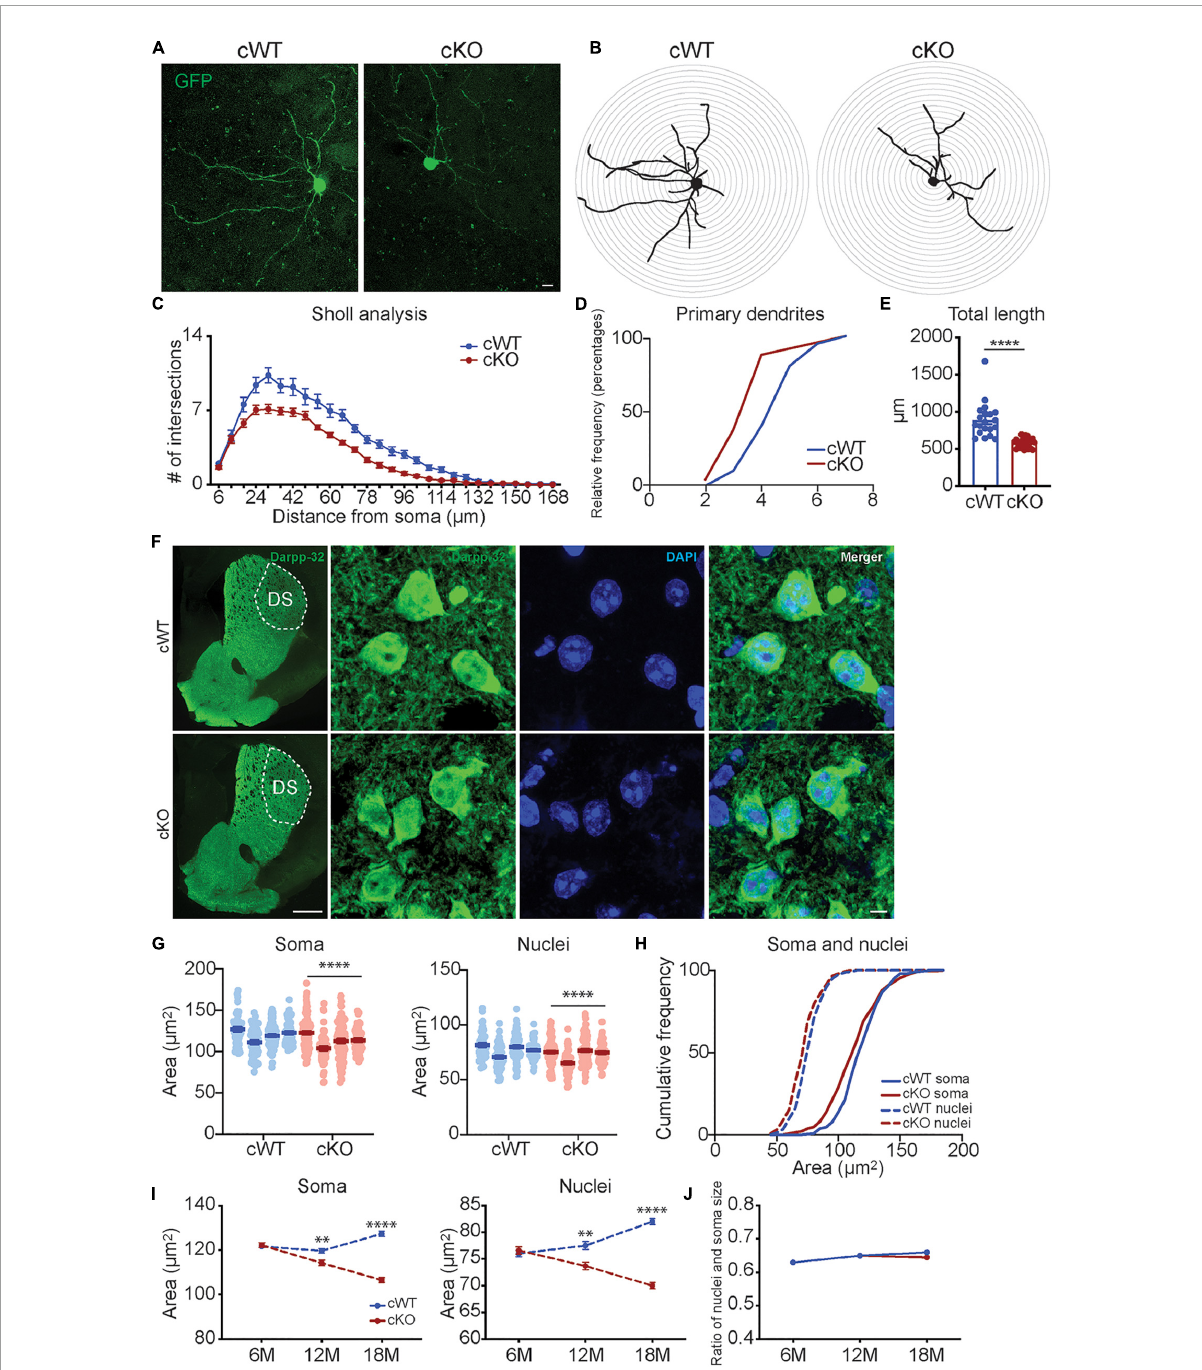
FIGURE3 Analyses of neuronal morphology in Pitx3 cKO mice during aging. (A) The GFP-labeled individual MSN in 12-month-old Pitx3 cWT and Pitx3 cKO mice (scale bar: 10 µ m). (B,C) Sholl analysis of dendritic complexity of GFP-labeled MSNs in 12-month-old Pitx3 cWT and Pitx3 cKO mice ( N = 3 mice per genotype; 5–8 neurons per mouse were counted). Benjamin- Hochberg multiple comparison test of dendritic complexity at 18, 24, 30, 36, 42, 54, 60, 66, 72, 78, 84, 90, 96, 102, 108, and 114 µ m from soma, q ≤ 0.05. (D) Analyses of primary dendrites ( N = 3 mice per genotype; 5–8 neurons per mouse were counted; all males). (E) Dendritic length of GFP-labeled MSNs in 12-month-old Pitx3 cWT and Pitx3 cKO mice ( N = 3 mice per genotype; 5–8 neurons per mouse were counted) unpaired t -test, ∗∗∗∗ p < 0.0001. (F) Co-staining of Darpp32 and DAPI in MSNs of 12-month-old Pitx3 cWT and Pitx3 cKO mice (scale bar: 500 µ m; high-magnification, 5 µ m). (G) The soma and nucleus size of MSNs in 12-month-old Pitx3 cWT and Pitx3 cKO mice ( N = 4 mice per genotype; all males). Conditional logistic regression test, ∗∗∗∗ p < 0.0001. (H) Cumulative frequency of the soma and nuclear size distribution in MSNs of 12-month-old Pitx3 cWT and Pitx3 cKO mice. (I) The soma and